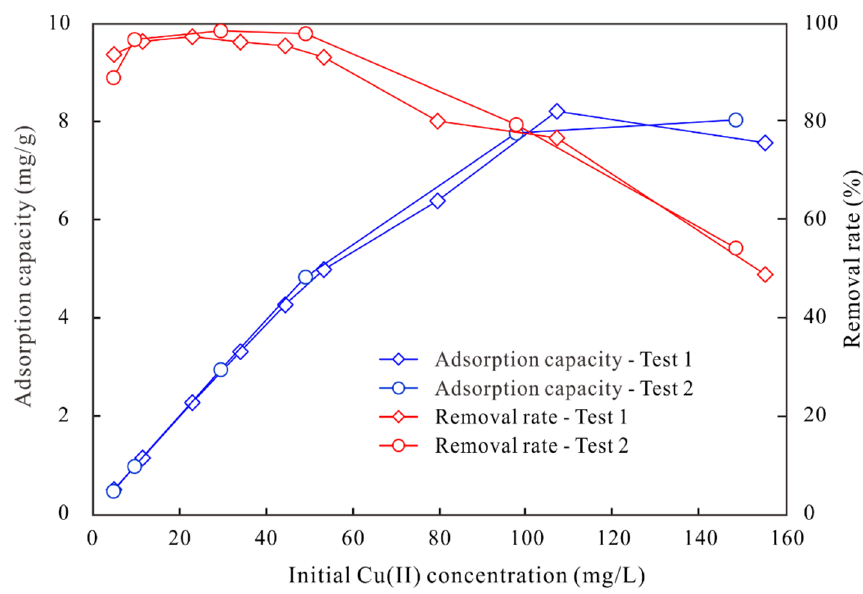
Figure A1. Result of the repeated experiments at different initial Cu(II) concentrations (temperature 25 °C, initial solution pH 5, adsorbent dose 0.5 g/50 mL, adsorbent particles size <100 mesh, reaction time 24 h).